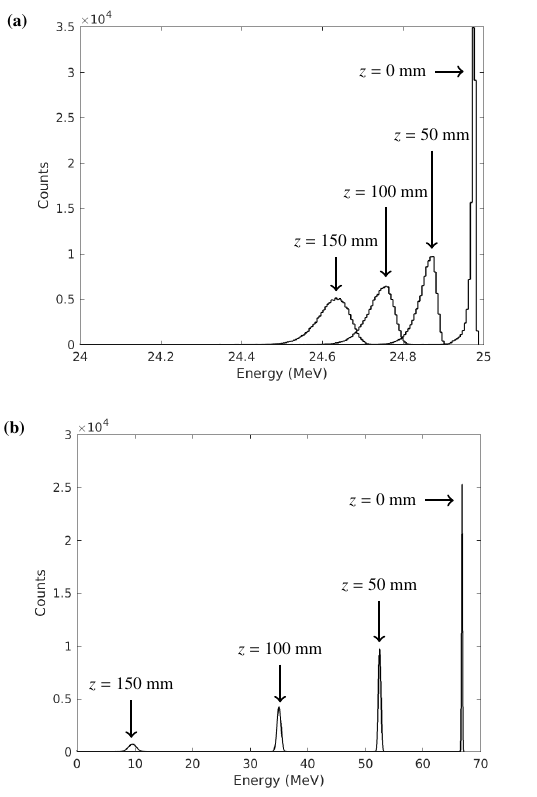
Figure 3. Energy spectrum for (a) 25MeV proton and (b) 70MeV carbon ion beam traversing in the air after the 10 µ m Mylar exit